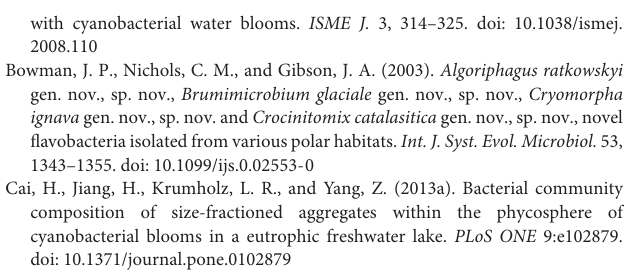
FIGURE S1 | The number of identified taxa at different levels based on total sequences (a) , the Venn diagrams (b) for taxa number of PAB (gray-tinted cycles with dashed) and FLB (white cycles with solid line). FIGURE S2 | Distribution of bacterial taxa at phylum level based on sequence data of Resample 1. Sample names with a and b represent the PAB and FLB,